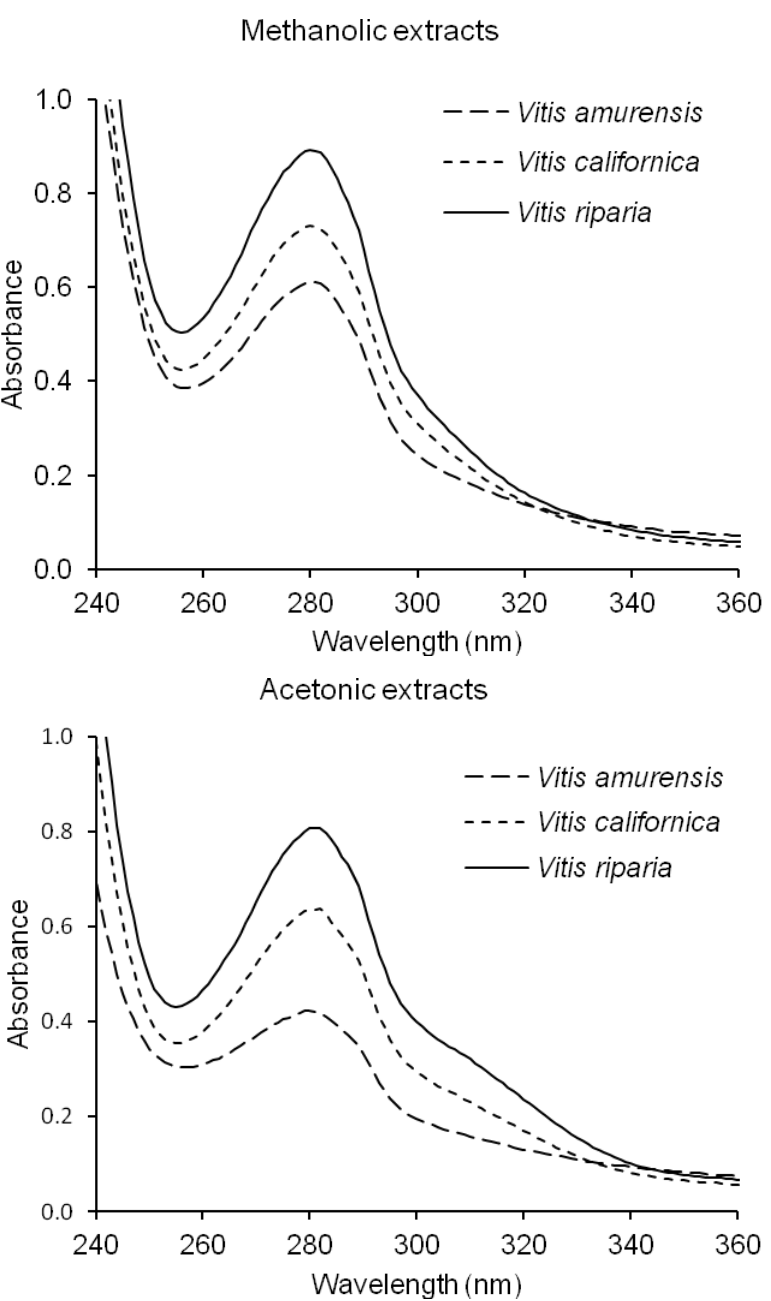
Figure 1. UV spectra of methanolic and acetonic extracts of grapevine